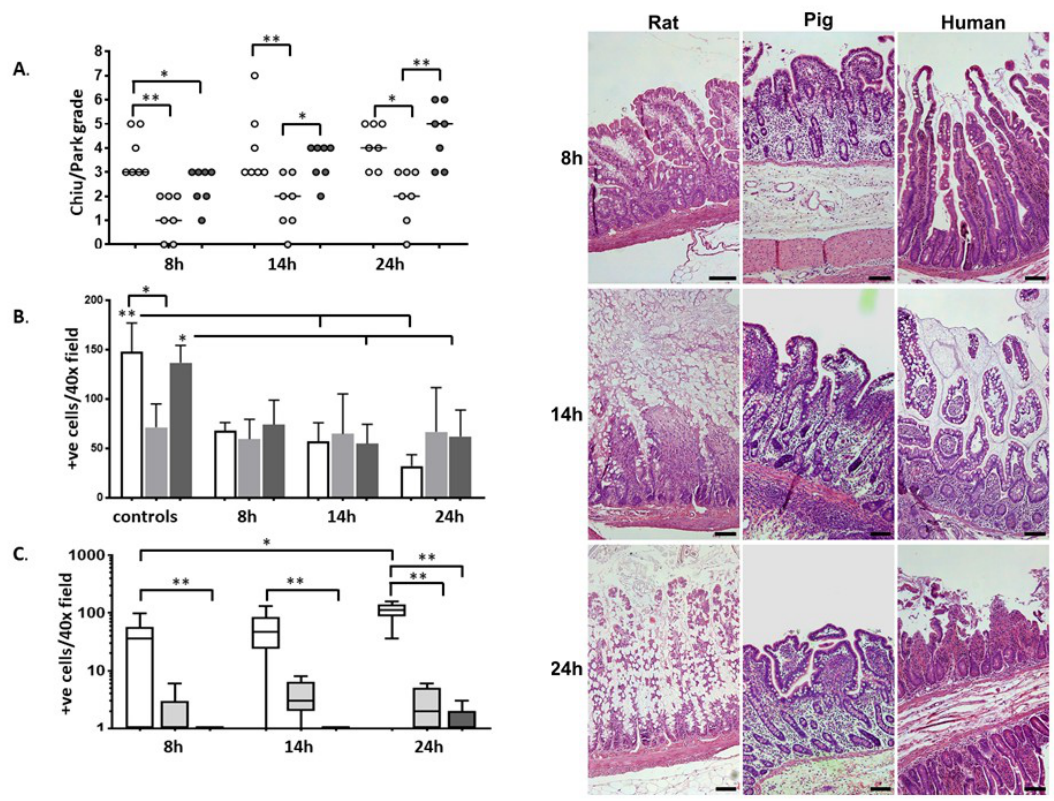
Figure 1. Light microscopy of rat (white), pig (light grey), and human (dark grey) intestines after different periods of cold storage (CS). ( A ) Summary of the tissue injury (Chiu score) induced by CS with each dot representing one individual ( n = 7) and the bar showing the median value; ( B ) goblet cell count; ( C ) enterocyte apoptosis quantified by caspase-3 positive cells (box plot showing the median, 5–95th percentile, and lowest and highest values at each time point). * p < 0.05, ** p < 0.01. A large number of apoptotic enterocytes (positive for active caspase-3) were found in rat intestines after 8 h of CS. Rat intestines had more apoptotic enterocytes than human intestines at all time points (Figure 1C). Right: representative microphotographs from each species at each of the three time-points (hematoxillin eosin stain, original magnification ×100, scale bar 100 microns). Normal pig intestines had significantly higher enterocyte density and significantly fewer polymorphonuclear neutrophils (PMN) in the villi compared to rat and human intestines (Figure 2).